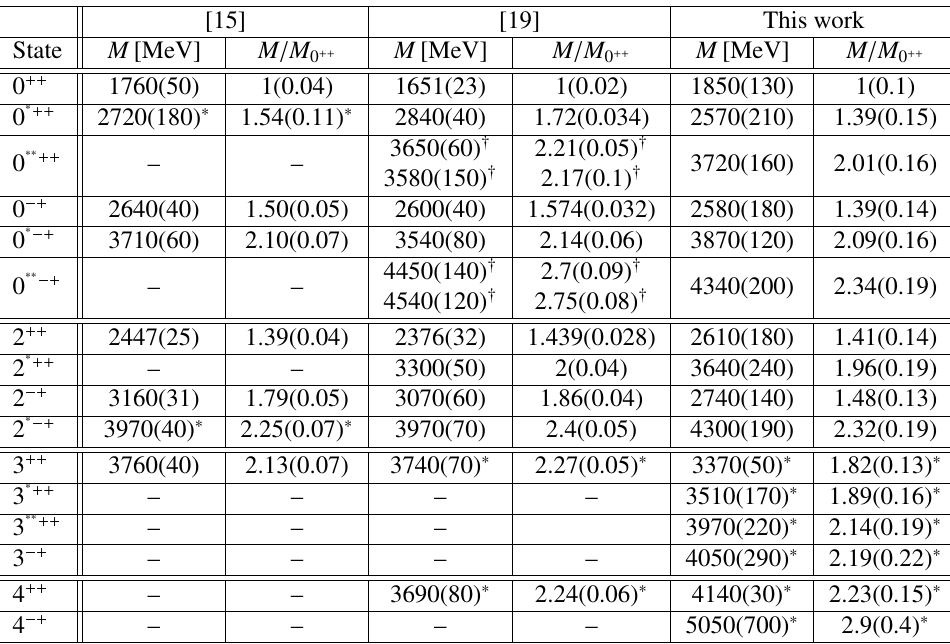
Table 1. Ground and excited state masses M of glueballs for various quantum numbers. Compared are lattice results from [15, 19] with the functional results of [21, 22]. For [15], the errors are the combined errors from statistics and the use of an anisotropic lattices. For [19], the error is statistical only. In our results, the error comes from the extrapolation method and should be considered a lower bound on errors. All results use the same value for r 0 = 1 / (418(5)MeV). The related error is not included in the table. Masses with † are conjectured to be the second excited states. Masses with ∗ come with some uncertainty in their identification in the lattice case or in the trustworthiness of the extrapolated value in the BSE